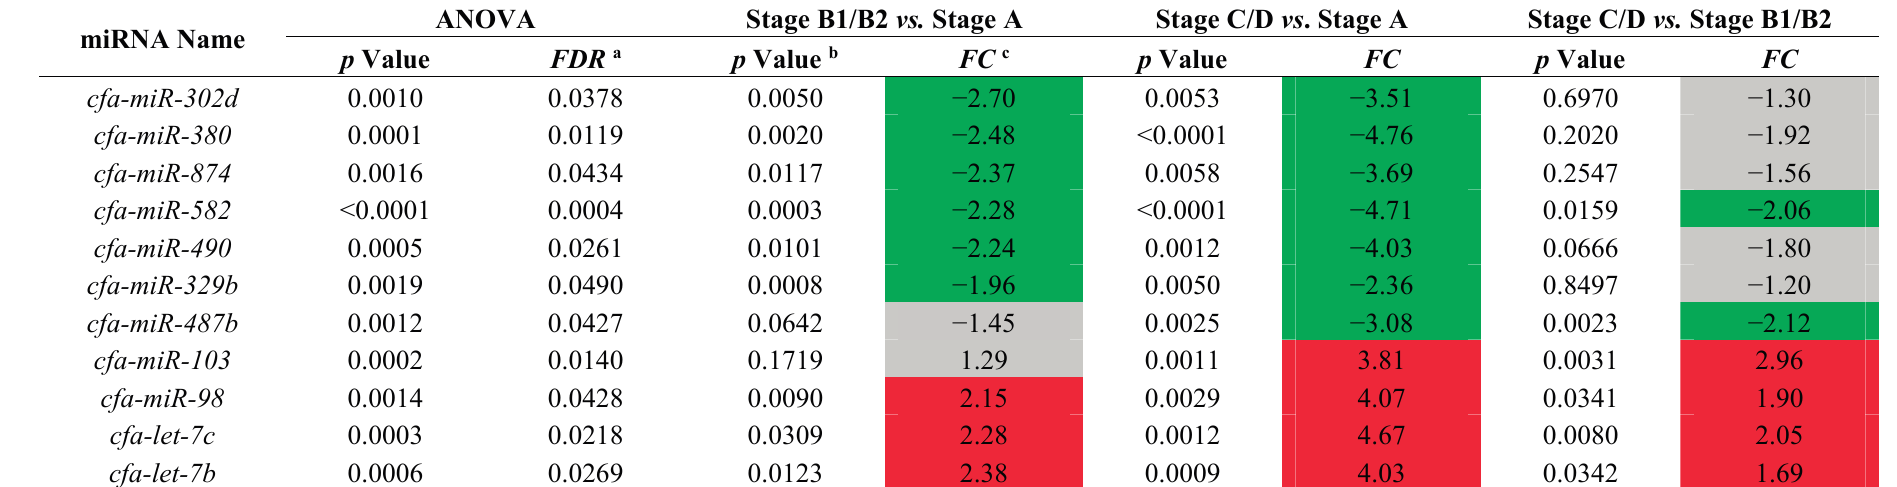
Table 1. Heat map of microRNAs differentially expressed between dogs in the three study groups ( n = 6/group): normal dogs at risk of heart disease (Stage A), asymptomatic dogs with myxomatous mitral valve disease (MMVD) and mild to moderate cardiac enlargement (Stage B1/B2) and dogs with MMVD and congestive heart failure requiring multiple cardiac medications (Stage